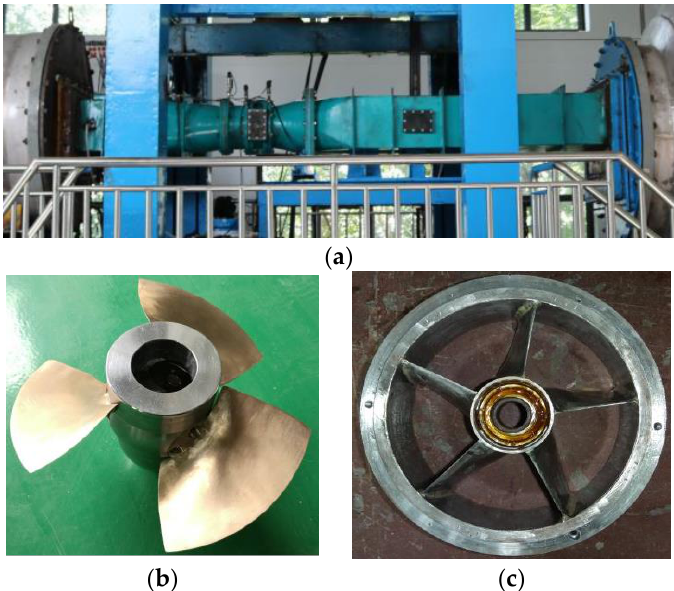
Figure 4. Physical diagrams of test: ( a ) pump device; ( b ) impeller; ( c ) guide vane.